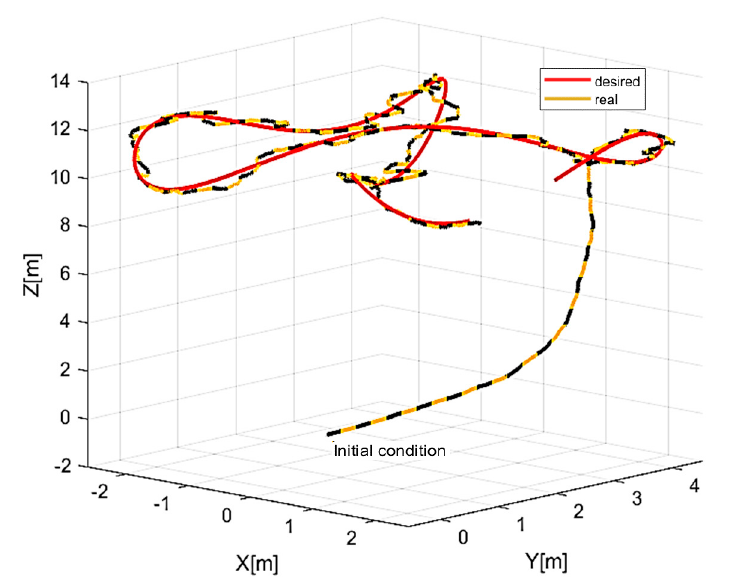
Figure 10. Trajectory tracking: Inverse Dynamics controller.